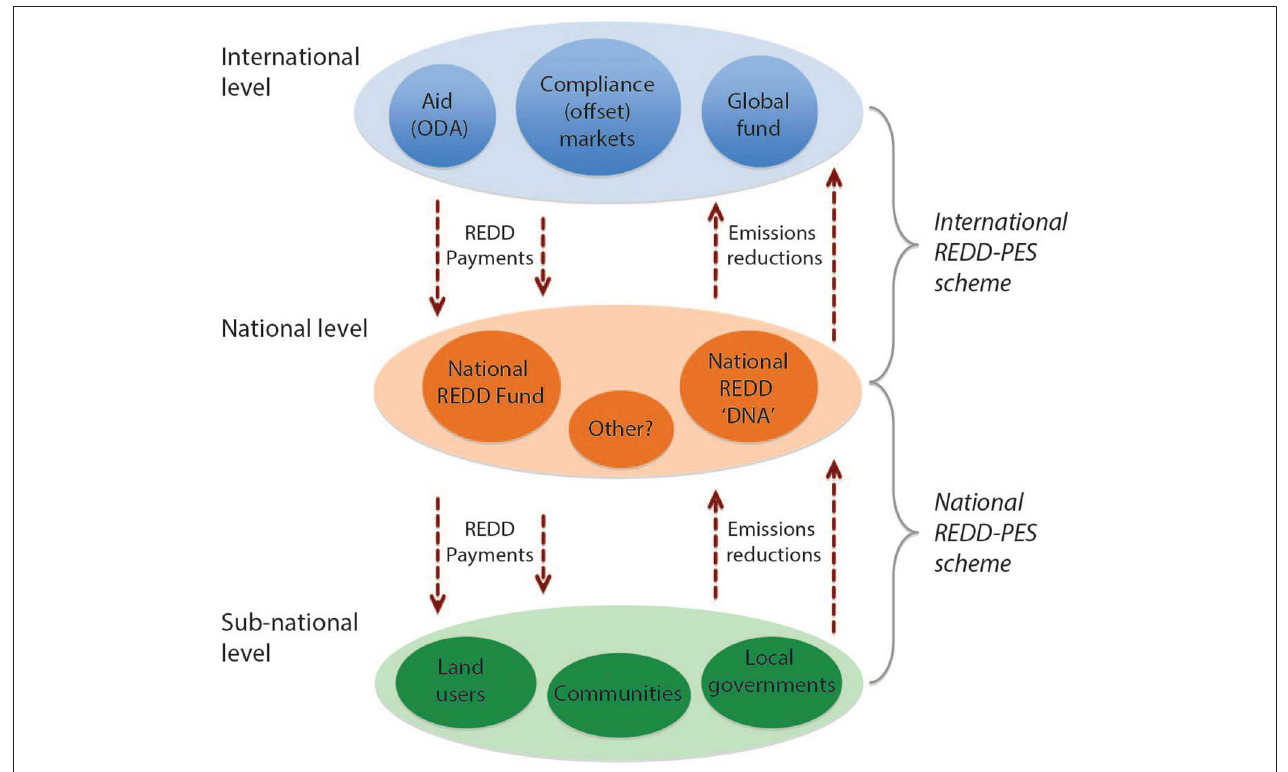
FIGURE 1 | Conceptual model of REDD + as a multi-level PES scheme. Source: Angelsen and Wertz-Kanounnikoff (2008, p. 12).